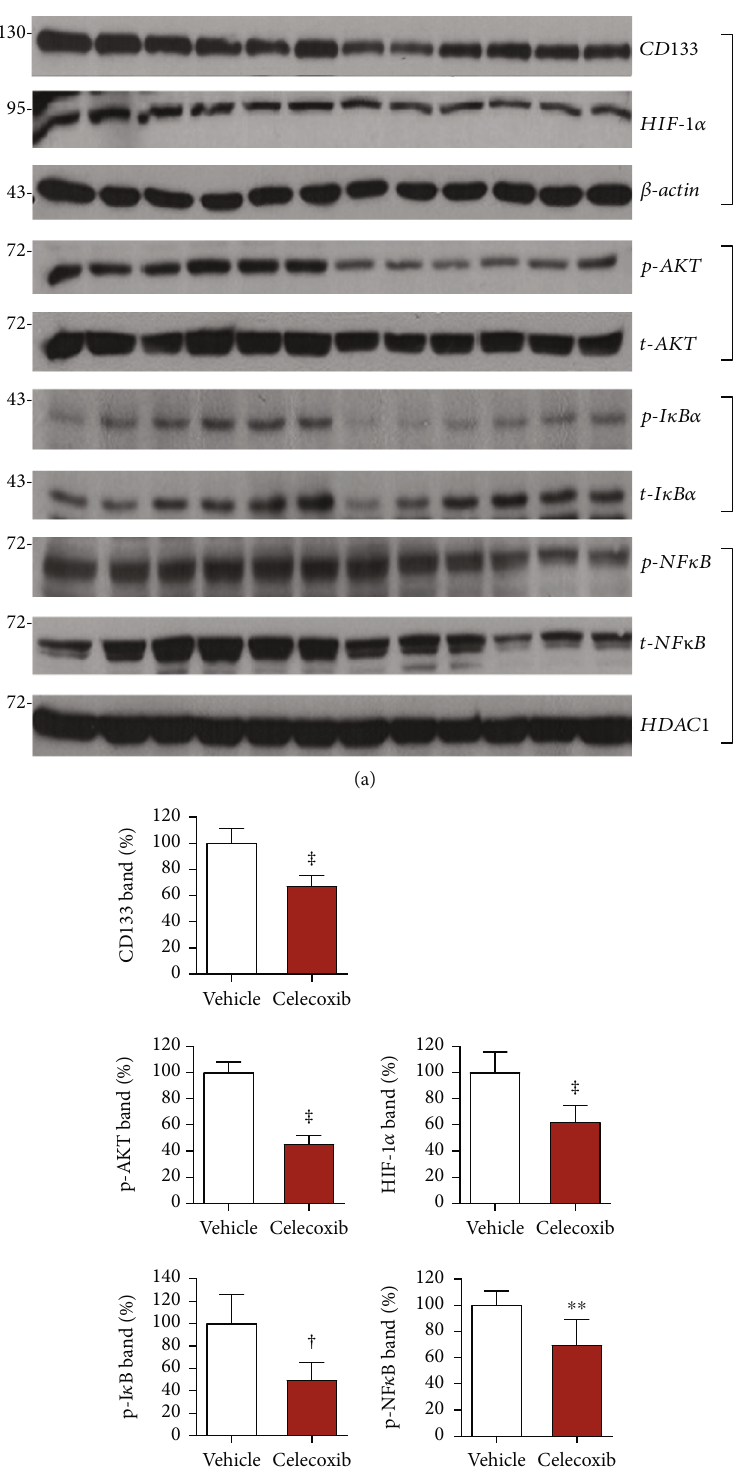
Figure 6: E ff ects of celecoxib on HT29 tumor expression of CD133 and signaling pathways. (a) Immunoblots of cellular CD133, p-AKT, HIF-1 α , and p-I κ B α and nuclear p-NF κ B. Tumor-bearing mice were intraperitoneally injected daily with vehicle or celecoxib for four consecutive days and were sacri fi ced on the day of the fi nal treatment. (b) Quanti fi ed band intensities of CD133 and HIF-1 α corrected by β -actin, p-AKT corrected by t-AKT, p-I κ B α corrected by t-I κ B α , and p-NF κ B corrected by HDAC1. Bars are mean ± SD of %ID/g obtained from six animals per group. ∗∗ P < 0 : 01 , † P < 0 : 005 , and ‡ P < 0 : 001